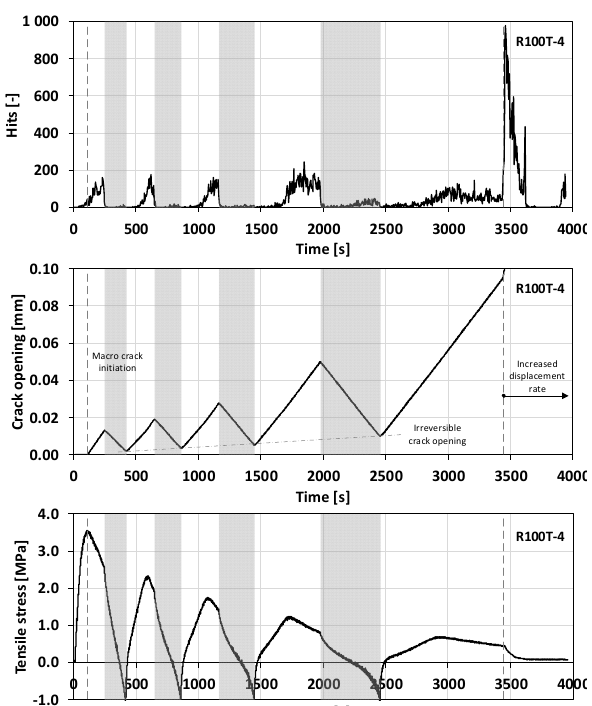
Figure 12. Cyclic tensile test results summarized as Hit ‐ time relation (upper), Crack opening ‐ time relation (middle) and Stress ‐ time relation (lower) for R100T ‐ 4.